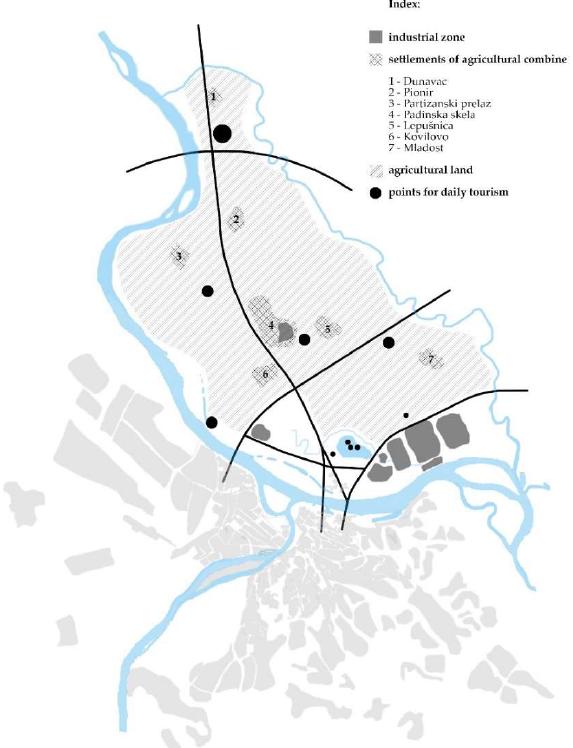
Figure 5. Urbanization plan of Belgrade on the Left Bank of the Danube—General urban solution from 1968. Source: Authors drawing based on [62]